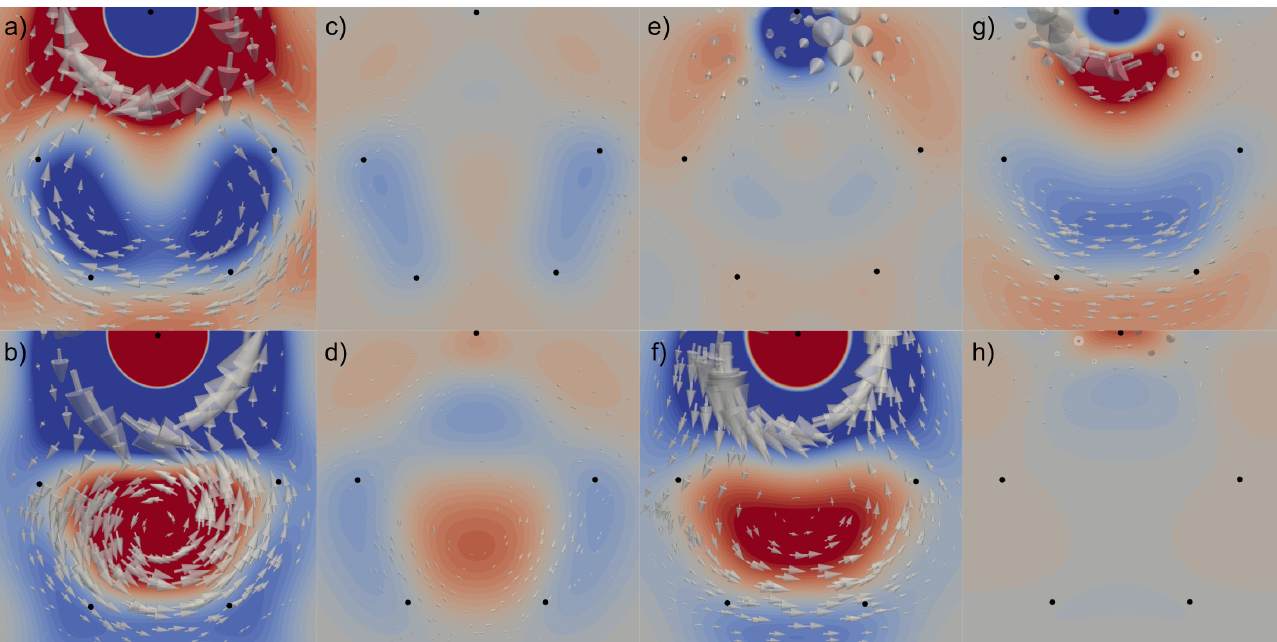
Figure 1. j ( r ) and tp j ( r ) maps of complexes 5 ( a ) and 6 ( b ). The contributions to j ( r ) of HOMO ( c , d ), HOMO-1 ( e , f ) and HOMO-2 ( g , h ) are also shown. Colour code: ≤− 3.0 × 10 − 4 a.u. (dark blue), 0.0 a.u. (white) and ≥ 3.0 × 10 − 4 a.u. (red). The plane is parallel to the ring at 1.0 Å from it. The magnetic field, B , is pointing toward the observer, then clockwise/anticlockwise currents are diatropic/paratropic.